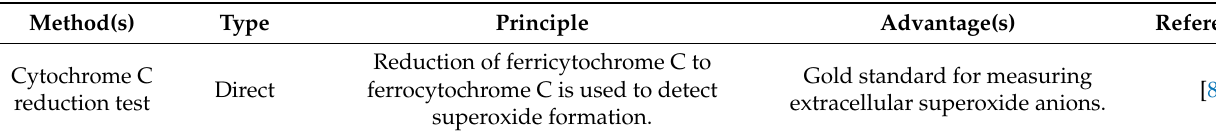
Table 2. Methods of measuring reactive nitrogen species